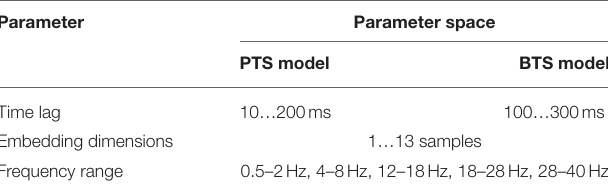
TABLE 1 | The parameter space used for optimal parameter